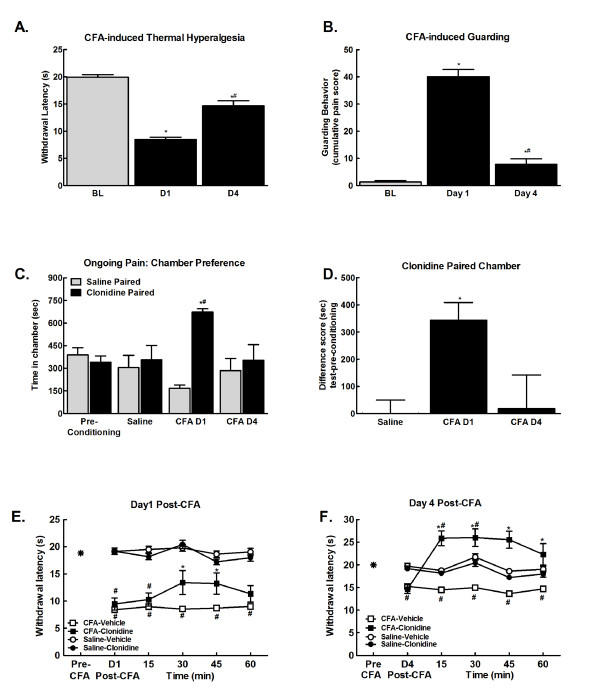
A. Hindpaw CFA produced lower paw withdrawal latencies within 24 hours (D1). Paw withdrawal latencies remained lower than pre-injury baseline (BL) 4 days following injury, but were higher than those observed 1 day following injury. *p < 0.05 vs. pre-injury thresholds (BL); #p < 0.05 vs. D1 thresholds, n = 7-8. B. Hindpaw CFA produced guarding behavior within 24 hours (D1). Guarding behavior remained elevated compared to pre-injury baselines (BL) 4 days following injury, but was significantly reduced compared to the D1 time-point. *p < 0.05 vs. pre-injury thresholds (BL); #p < 0.05 vs. D1 thresholds, n = 7-8. C. Spinal clonidine (10 μg) induced CPP selectively in CFA treated rats at day 1, but not day 4 post CFA, injection. No chamber preference is observed in saline treated rats indicating that this dose of spinal clonidine is not rewarding in the absence of injury. *p < 0.05 vs. saline paired chamber; #p < 0.05 vs. pre-conditioning, n = 7. D. Difference scores calculated as test time - preconditioning time spent in clonidine chamber confirm that CFA treated rats showed CPP 24 hrs, but not 4 days post CFA injection. *p < 0.05 vs. saline treated group. E. CFA decreased paw withdrawal latencies to radiant heat within 24 hours of injection (Post-CFA). Spinal clonidine (10 μg) attenuated, but did not fully reverse CFA-induced thermal hyperalgesia. This dose of spinal clonidine failed to induce antinociception in rats that received intraplantar saline, *p < 0.05 vs. post-CFA, #p < 0.05 vs. pre-CFA, n = 5-8. F. CFA-induced thermal hyperalgesia persisted through day 4 post-CFA. Spinal clonidine (10 μg) induced antihyperalgesia and antinociception, elevating paw withdrawal latencies above baseline values. *p < 0.05 vs. post-CFA, #p < 0.05 vs. pre-CFA, n = 5-8.